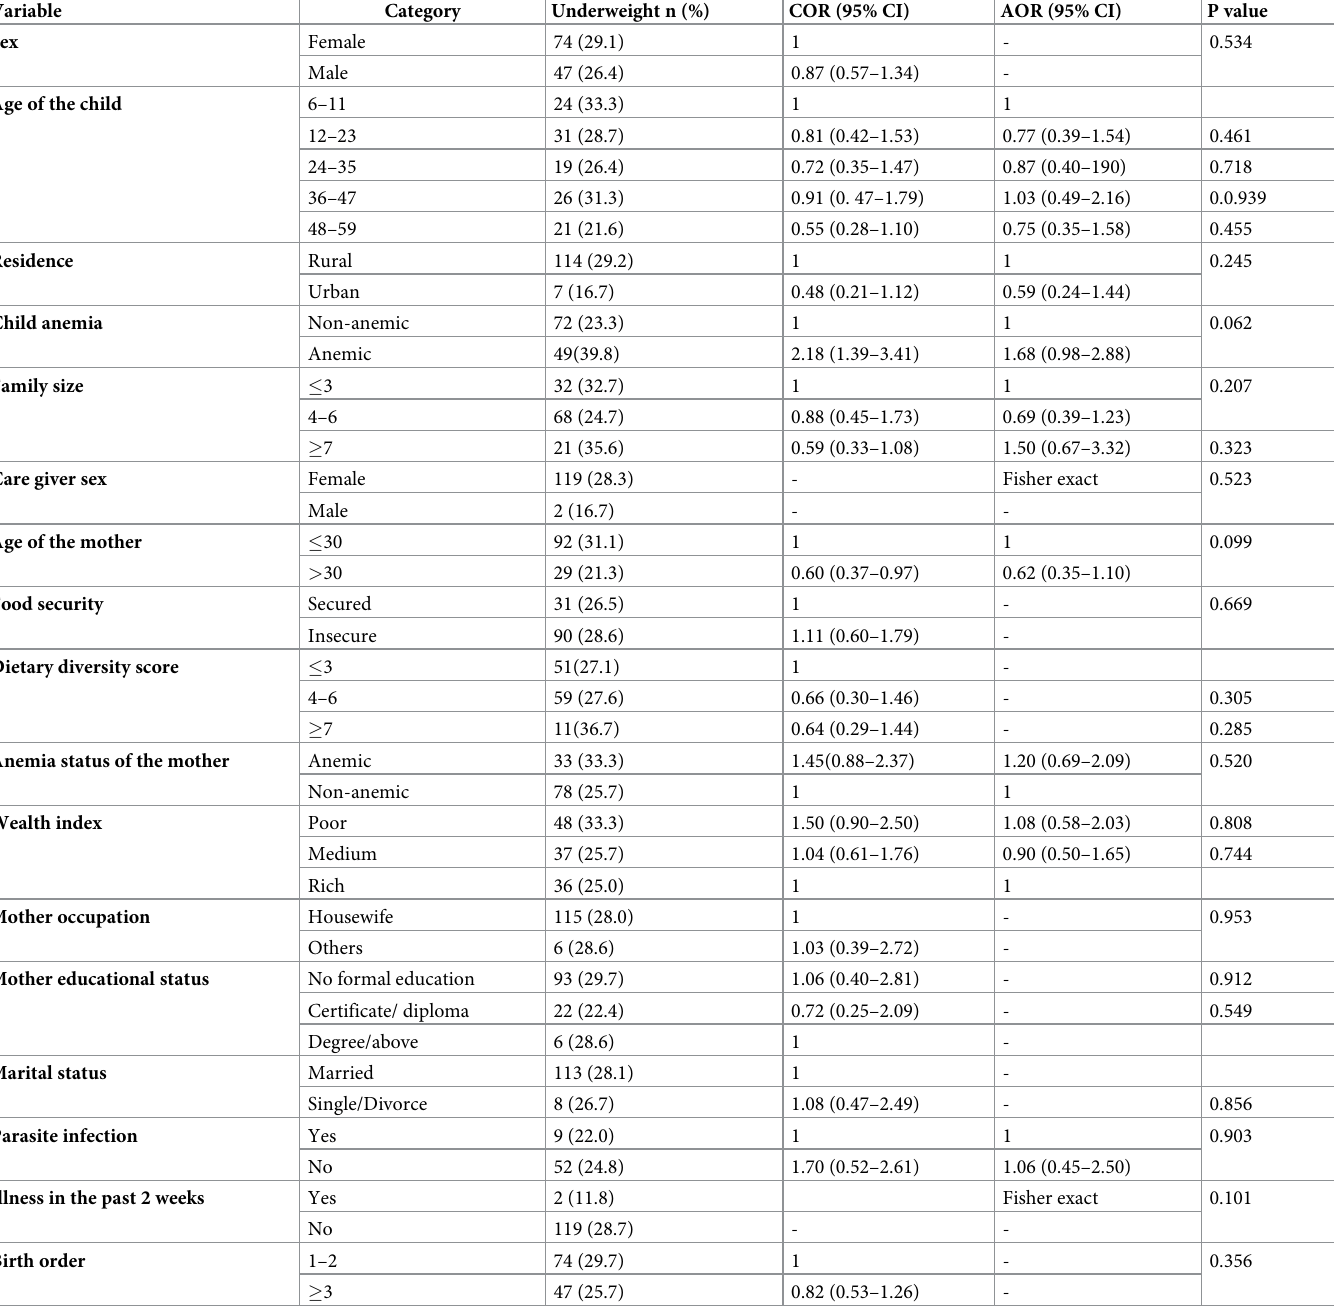
Table 5. Bi-variable and multi-variable logistic regression of underweight among children aged 6 to 59 months in the Menz Gera Midir district Northeast Ethiopia in 2021, (N = 432). Variable